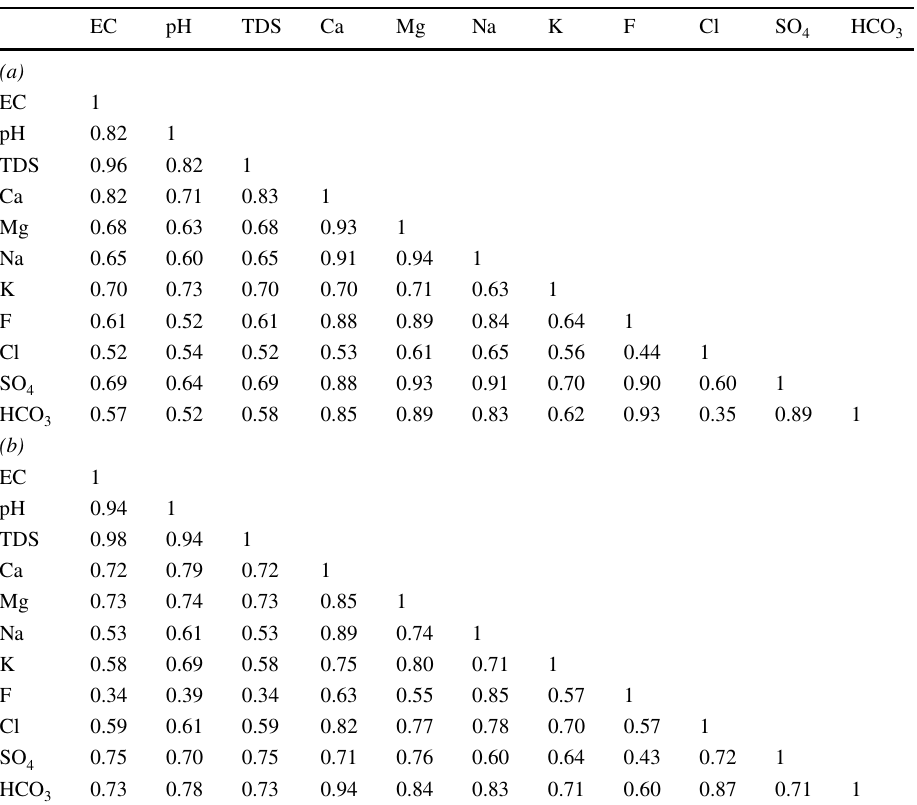
Table 8 Correlation matrix between different measured physicochemical parameters of Chaturangi glacier meltwater during the ablation period a 2015 and b 2016